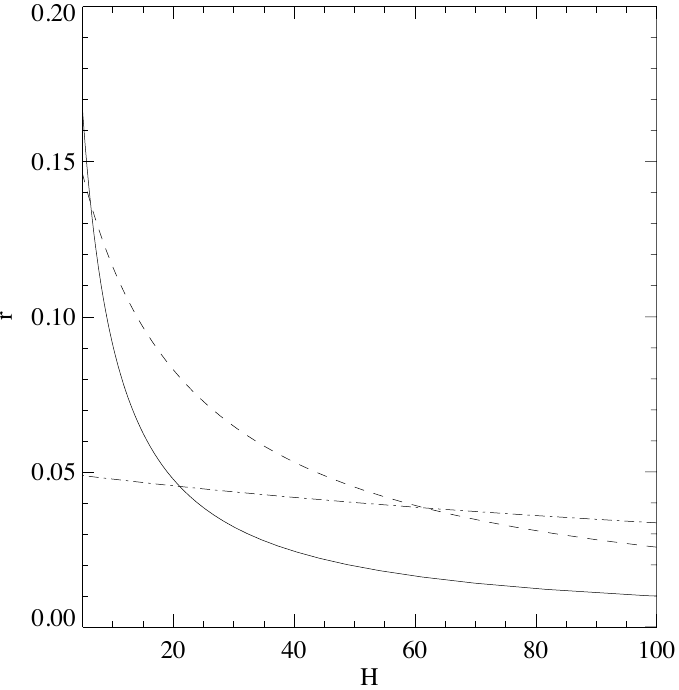
√ 2 for P m = 1 (solid line);